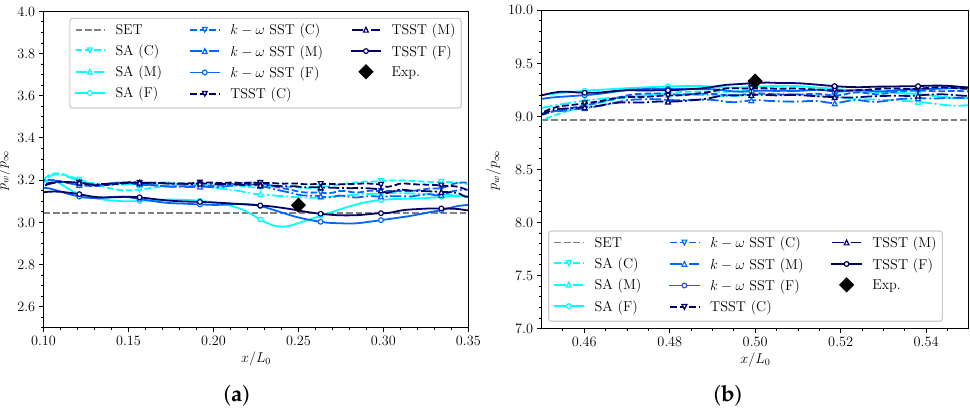
Figure 5. Non-dimensional surface pressure at the first and the second ramp surfaces as a function of the grid refinement and the turbulence model. Gray dashed line denotes the SET inviscid prediction while the black diamond denotes the mean-pressure signal experimentally acquired by Berto et al. [49]. ( a ) Wall pressure (ramp 1); ( b ) Wall pressure (ramp 2).